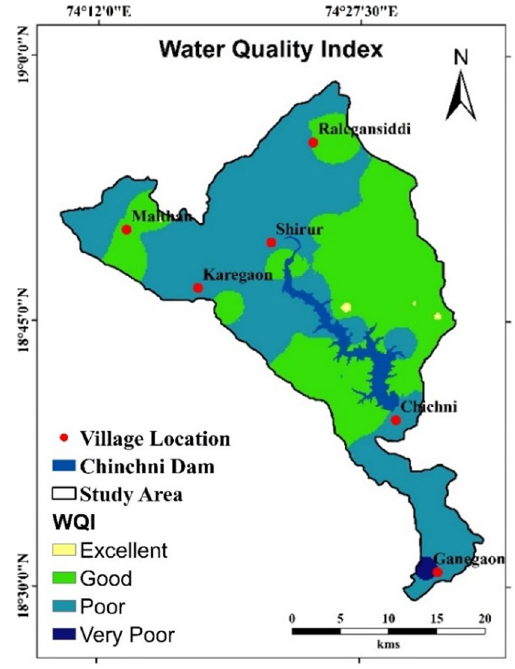
Fig. 4 Spatial variation in